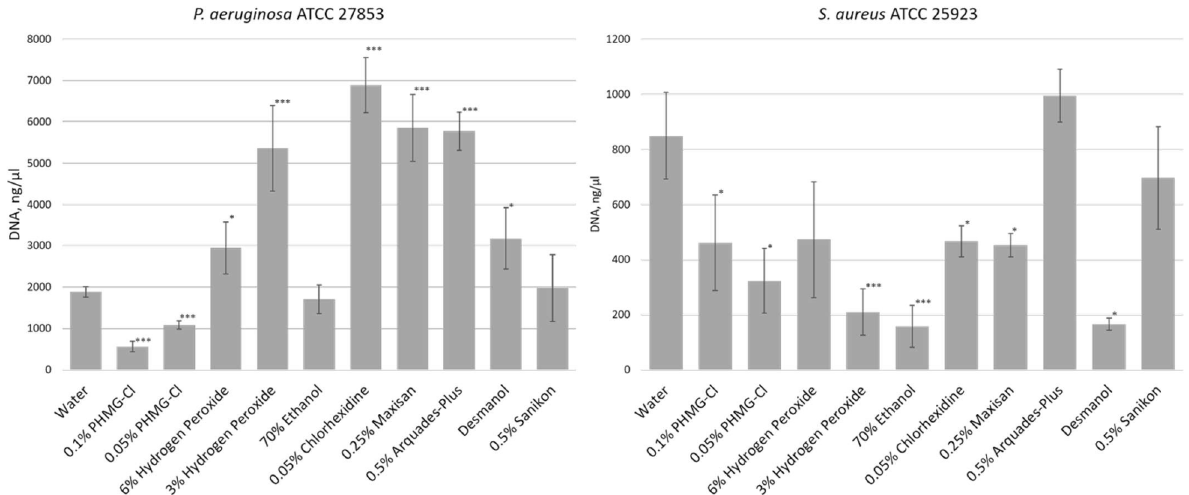
Figure 1. eDNA released from dehydrated Pseudomonas aeruginosa ATCC 27853 and Staphylococcus aureus ATCC 25923 biofilms after treatment with biocides. Shown here are eDNA yields (ng/ µ L) recovered from 5-day-old dehydrated biofilms after 1 h of exposure to biocides ( n = 3). Statistical significance compared to water exposure (control) when * p < 0.05 and *** p < 0.005.